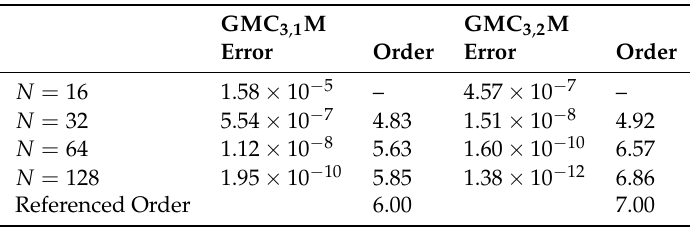
M for Example 1 , k 2